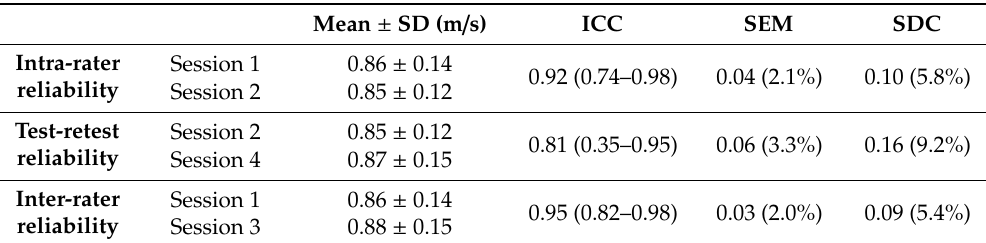
Table 10. Results of gait mean